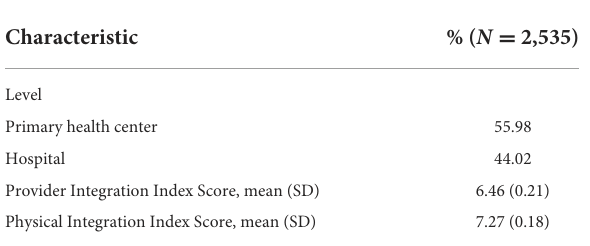
TABLE 1 Characteristics of married/cohabitating postpartum women attending facility for child